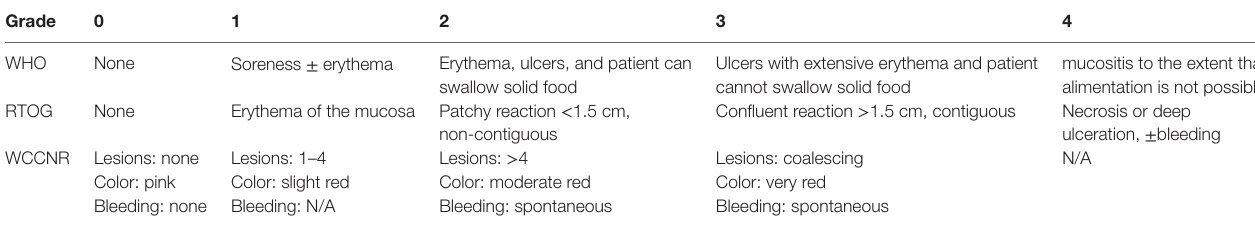
TAbLe 4 | Comparison of OM scoring scales (14,